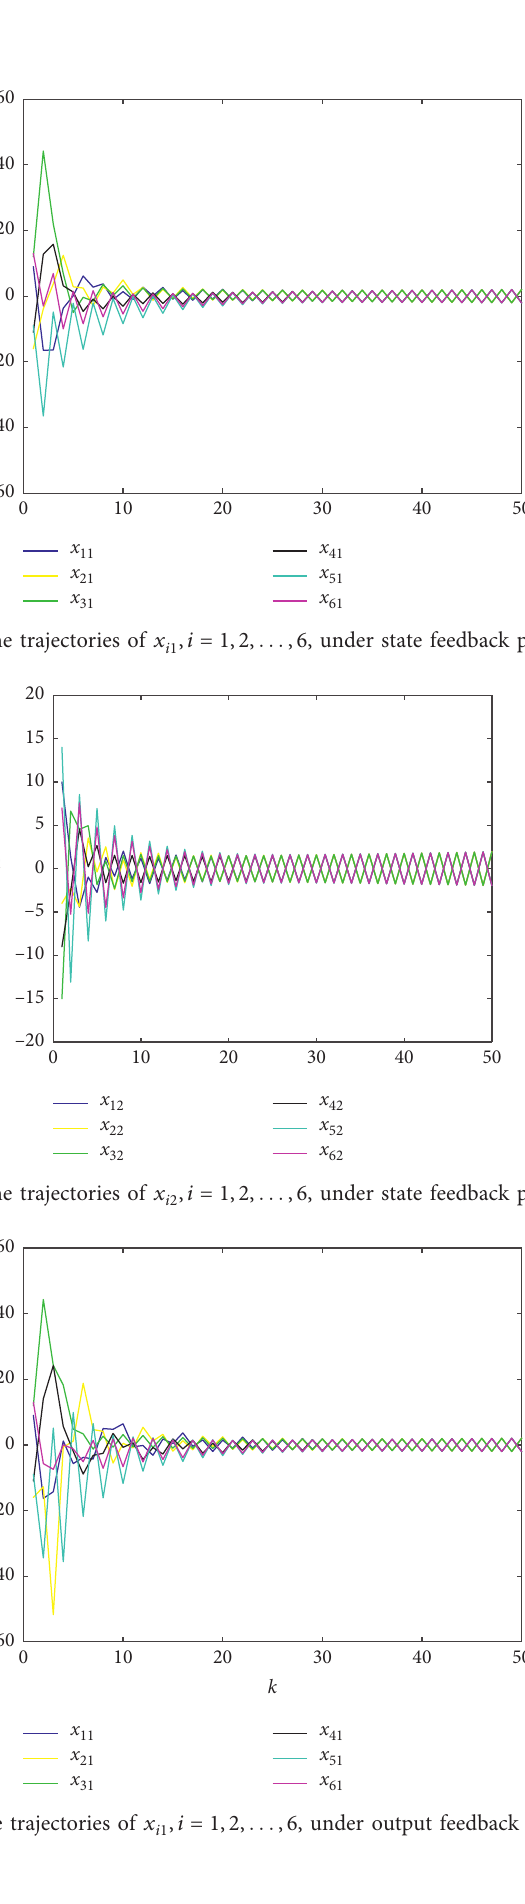
, i � 1 , 2 , ... , 6, under output feedback i 1